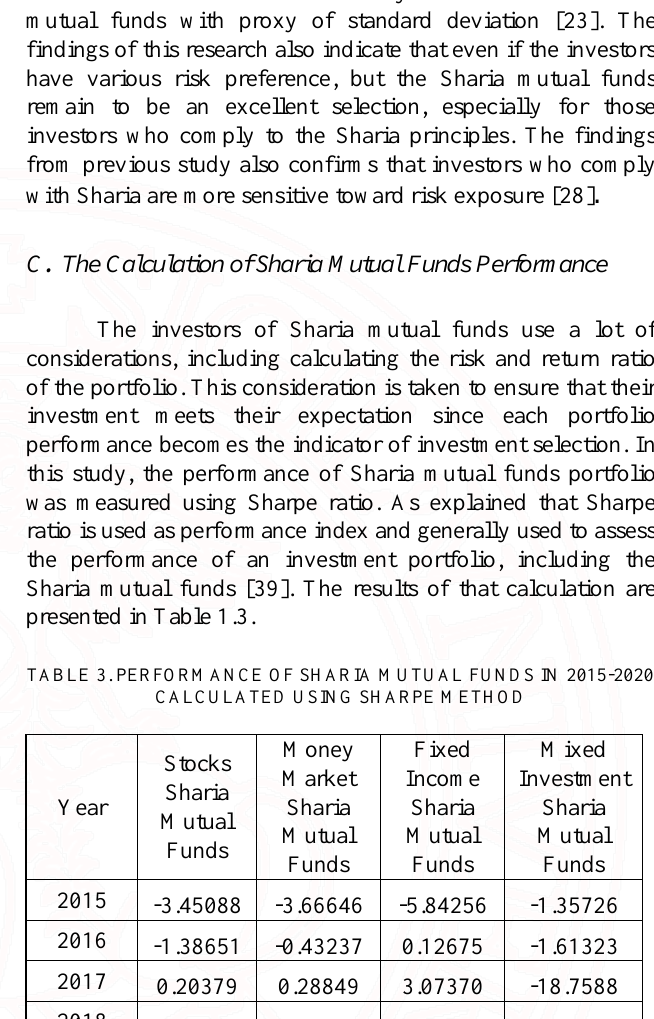
TABLE 2. AVERAGE RISKS OF SHARIA MUTUAL FUNDS